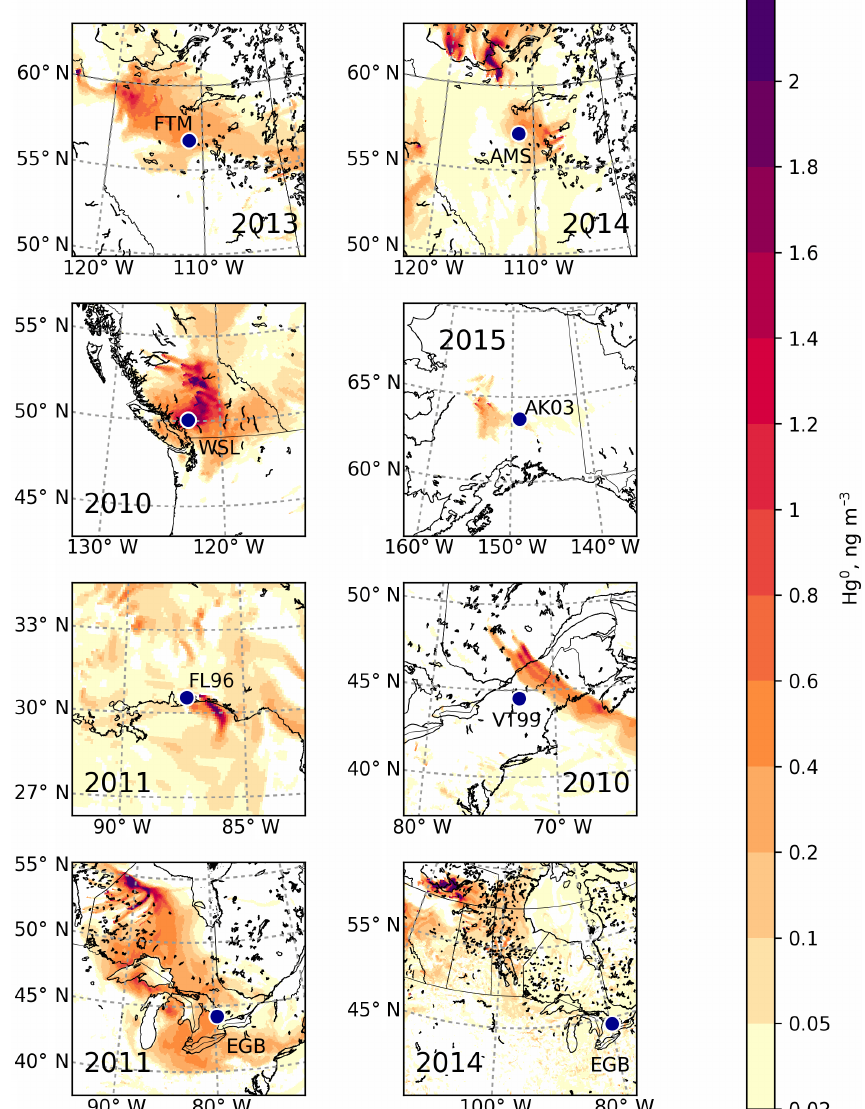
Figure 3. Examples of fire plumes (shown as surface air concentrations of Hg 0 ) showing typical source regions that impact the labelled station. Dots denote the location of an impacted observation station from Table